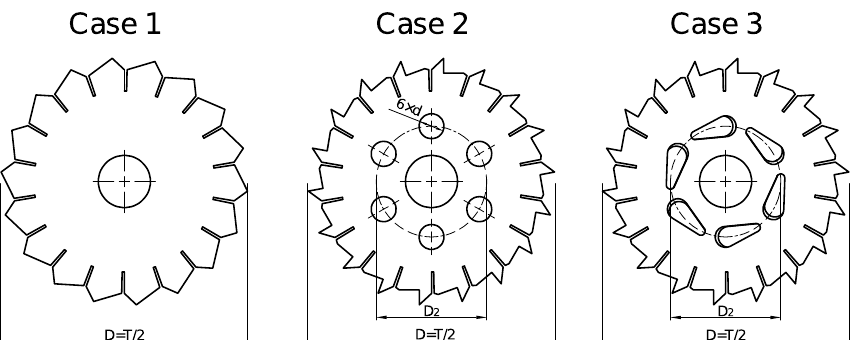
Figure 2. Impeller geometries. D is the impeller diameter, T is the internal tank diameter, d is the holes diameter, and D 2 is the diameter of a hole circle. Case 1 is the basic geometry and case 2 has cuts on the teeth and six holes drilled. In case 3, gaps are made instead of holes.